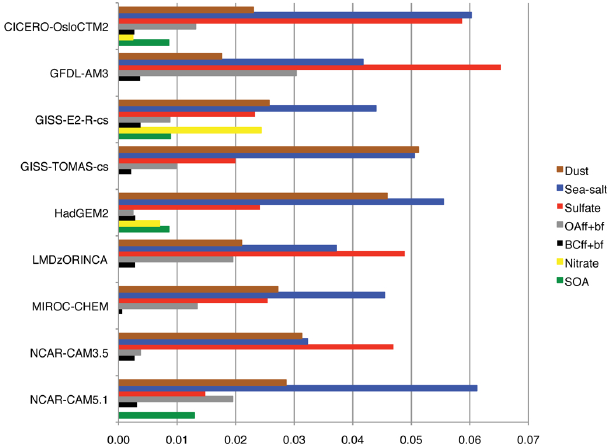
Fig. 3. Global mean annual average AOD (550nm) by component. Additional AOD of 0.06 is classified as aerosol water in CAM5.1. Clear-sky AOD is used for the GISS